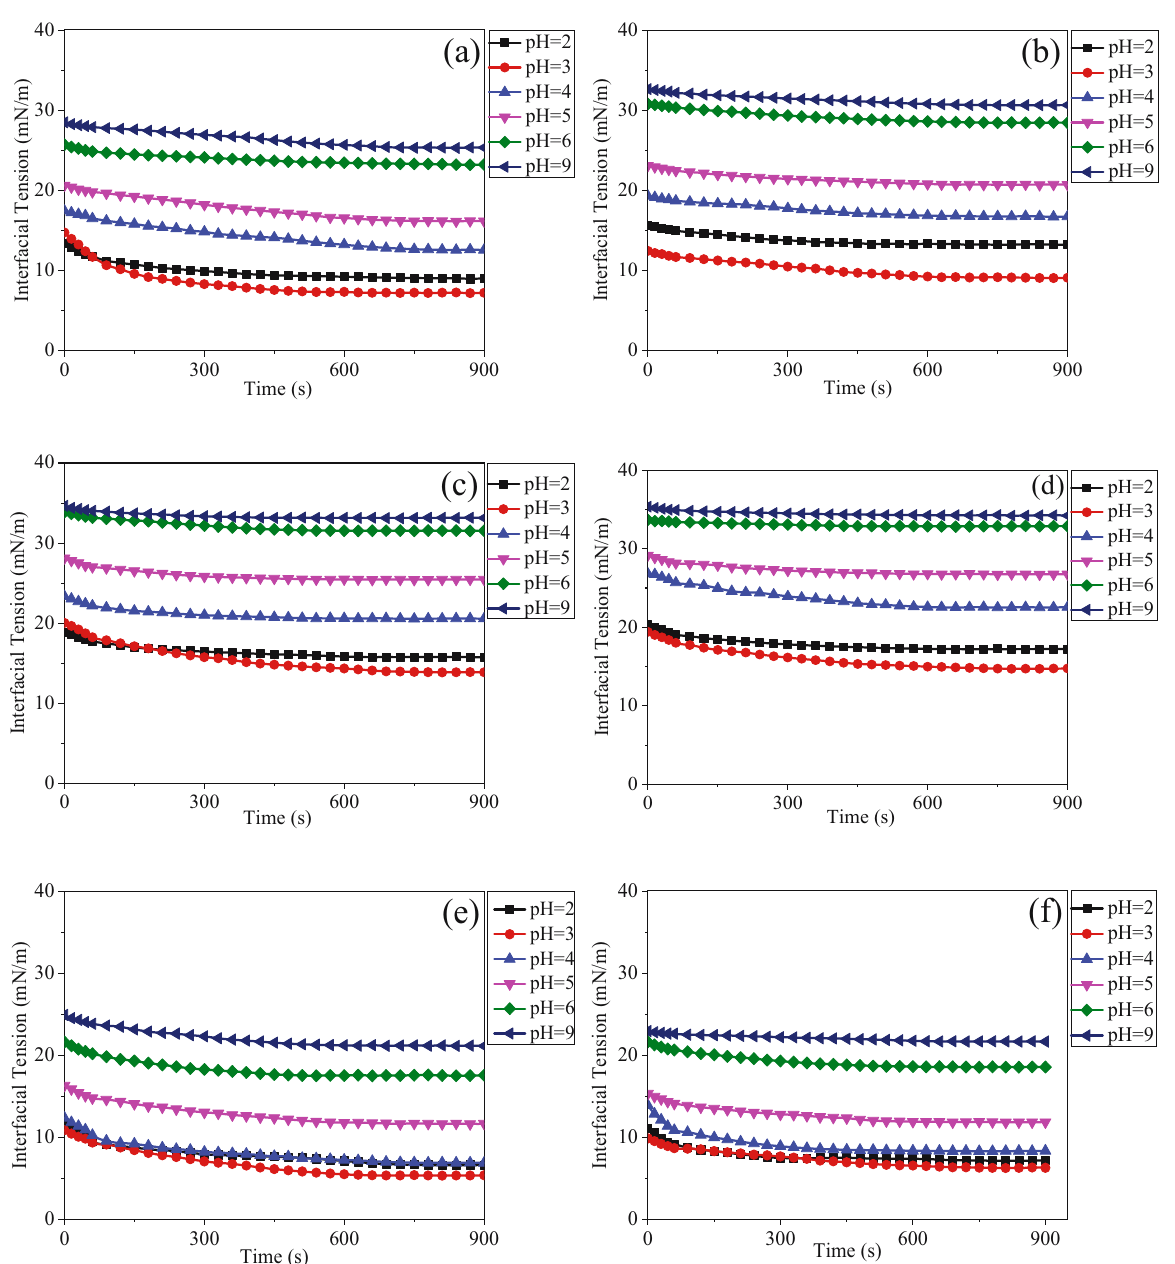
Figure 4: Aminated PS ( 1 mg/mL ) compounding with CNCs – OSO 3 H ( 10 mg/mL ) at various pHs. ( a ) PS – NH 2 ( M n ≈ 0.5k ) ; ( b ) PS – NH 2 ( M n ≈ 2.1k ) ; ( c ) PS – NH 2 ( M n ≈ 2.9k ) ; ( d ) PS – NH 2 ( M n ≈ 3.2k ) ; ( e ) H 2 N – PS – NH 2 ( M n ≈ 0.9k ) ; ( f ) H 2 N – PS – NH 2 ( M n ≈ 2.3k )